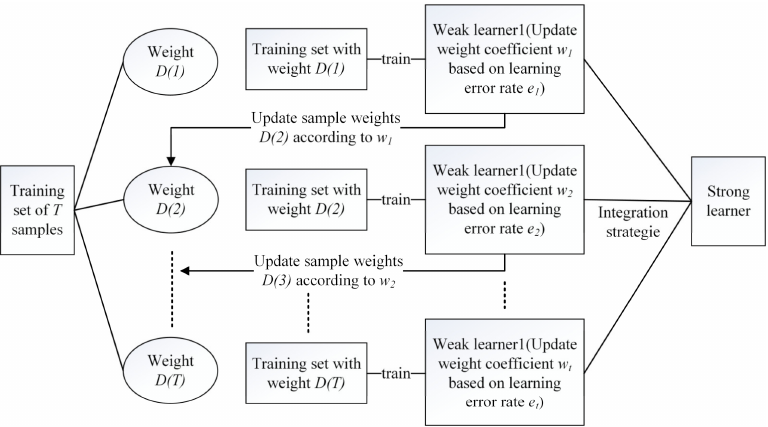
Figure 6. RUS Boost basic logic diagram.